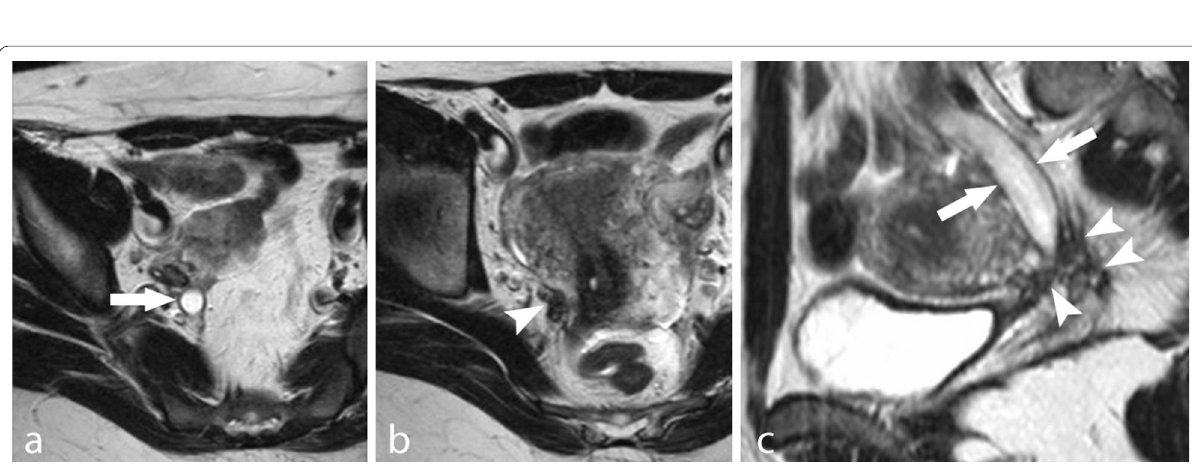
Fig. 11 DIE with right ureter infiltration. TSE T2w axial ( a , b ) and sagittal ( c ) images. A right para-uterine DIE nodule (arrowheads) infiltrates the distal tract of the right ureter, which is dilated